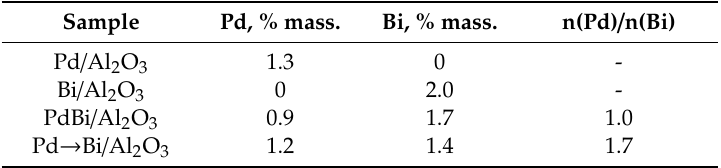
Table 1. Elemental analysis of obtained samples according to AES-MP data.